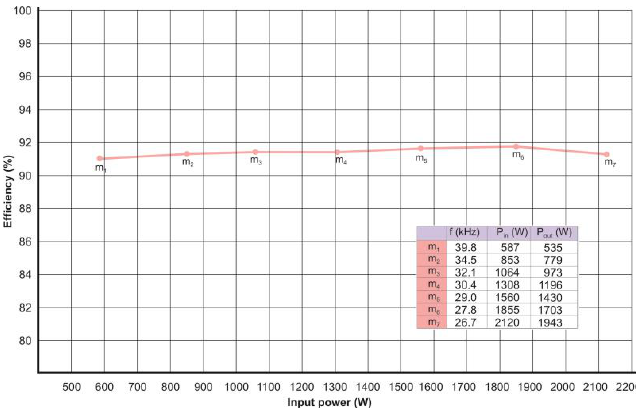
Figure 38. System efficiency.